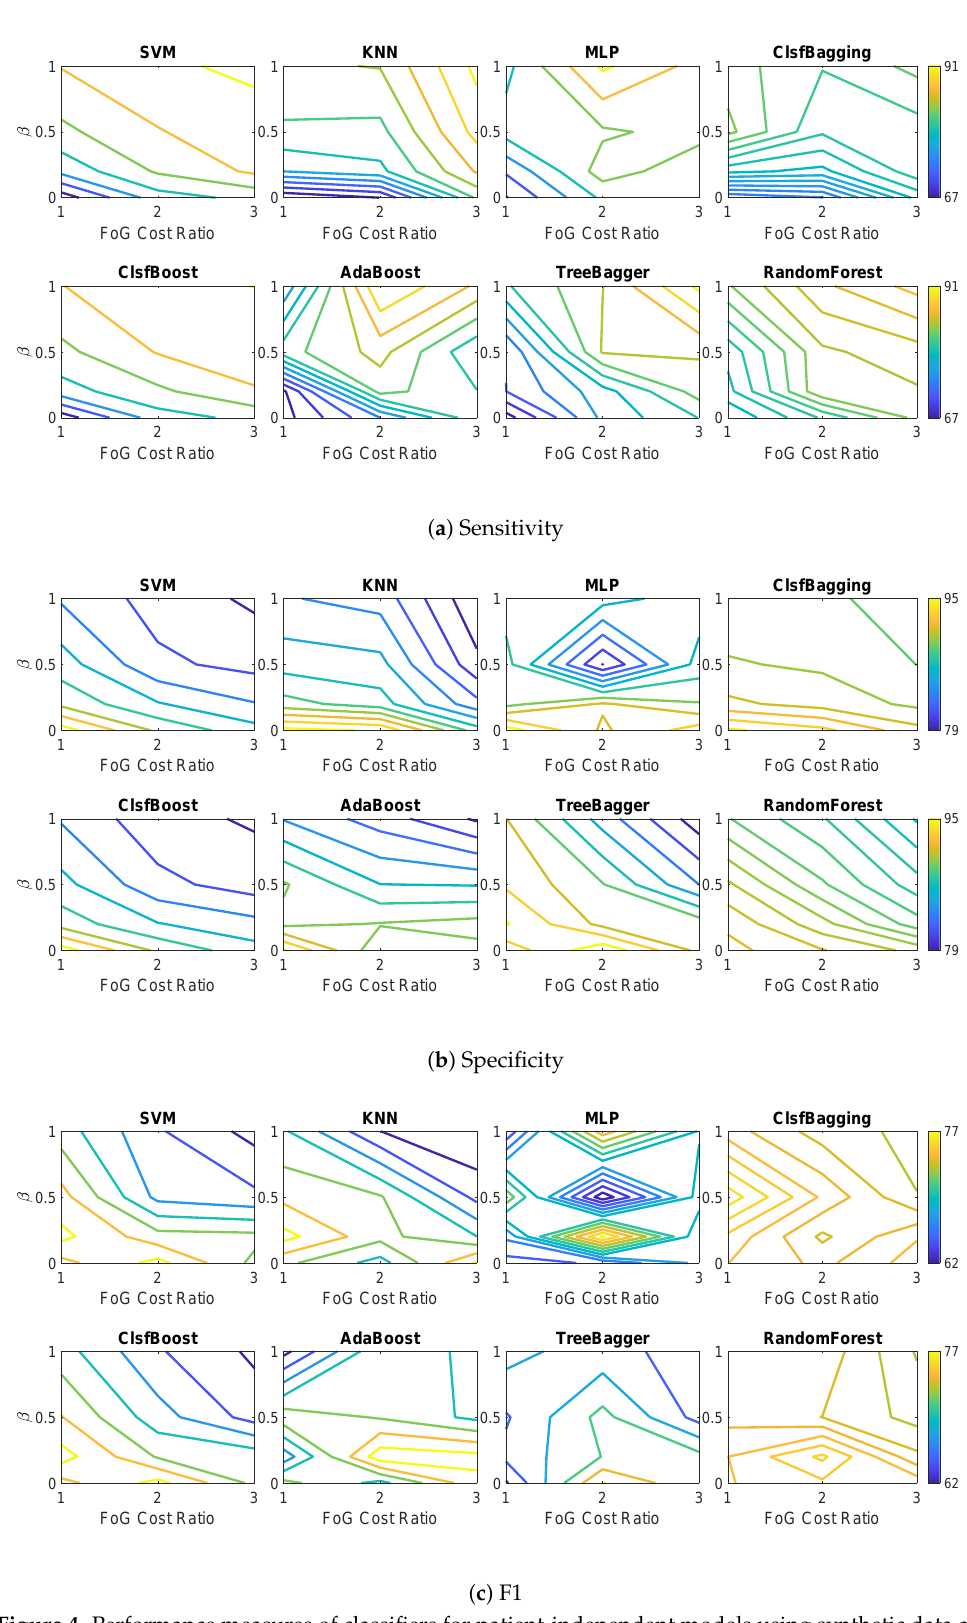
Figure 4. Performance measures of classifiers for patient-independent models using synthetic data and cost of